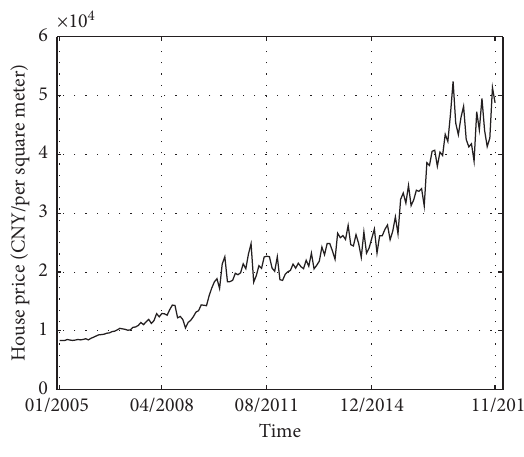
Figure 2: Monthly house prices in